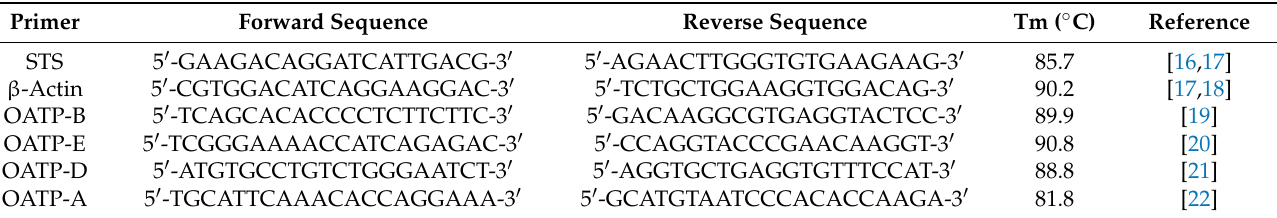
Table 1. Primer sequences used in real-time PCR